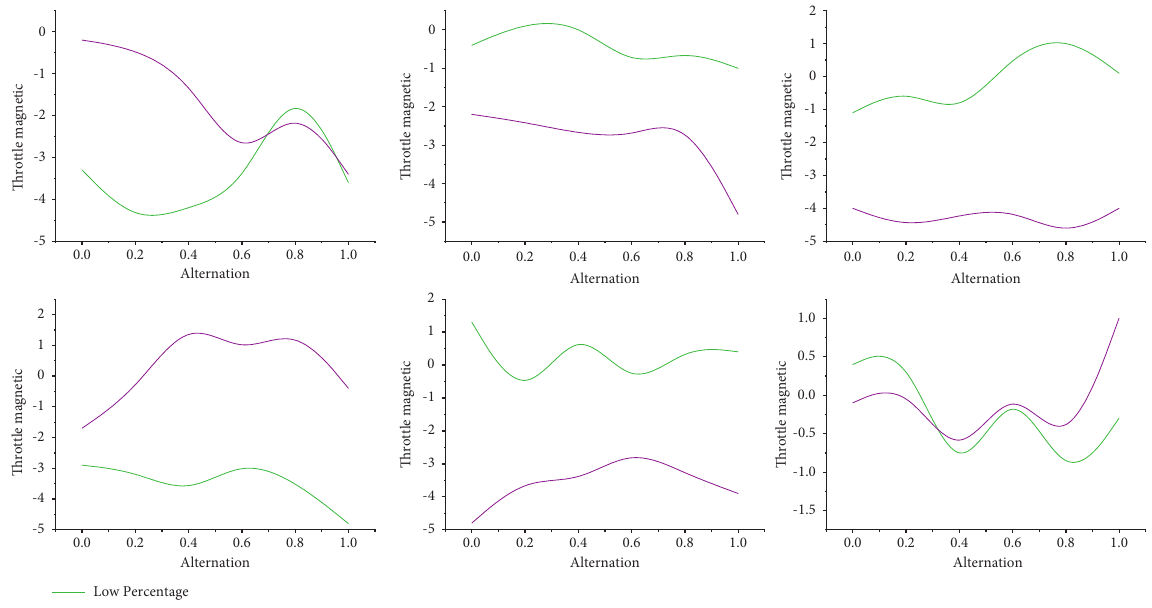
Figure 10: Influence of variable intensity magnetic field device on magnetic